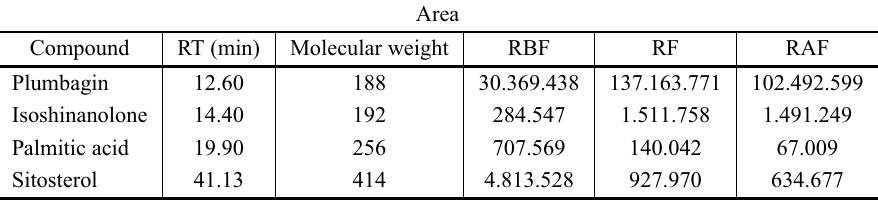
Compounds characterized in Plumbago scandens root extracts during different physiologic developmental